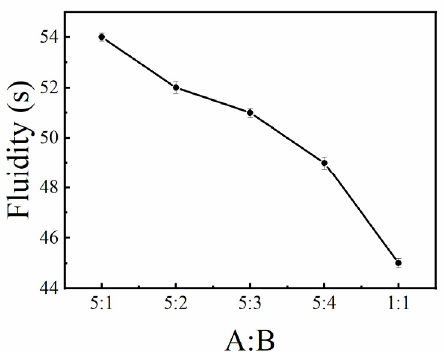
Figure 6. Effect of the ratio of A to B on the fluidity of the paste.